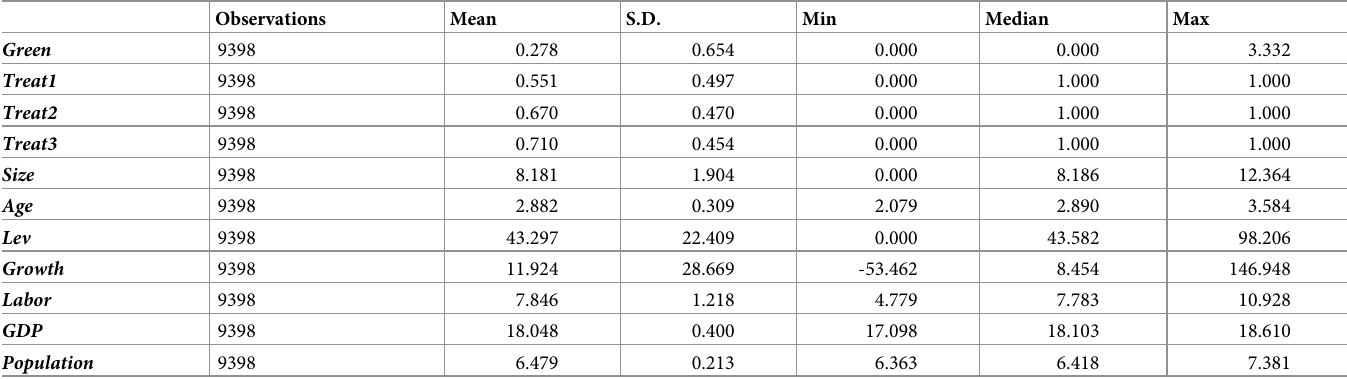
Table 2. Descriptive statistics.